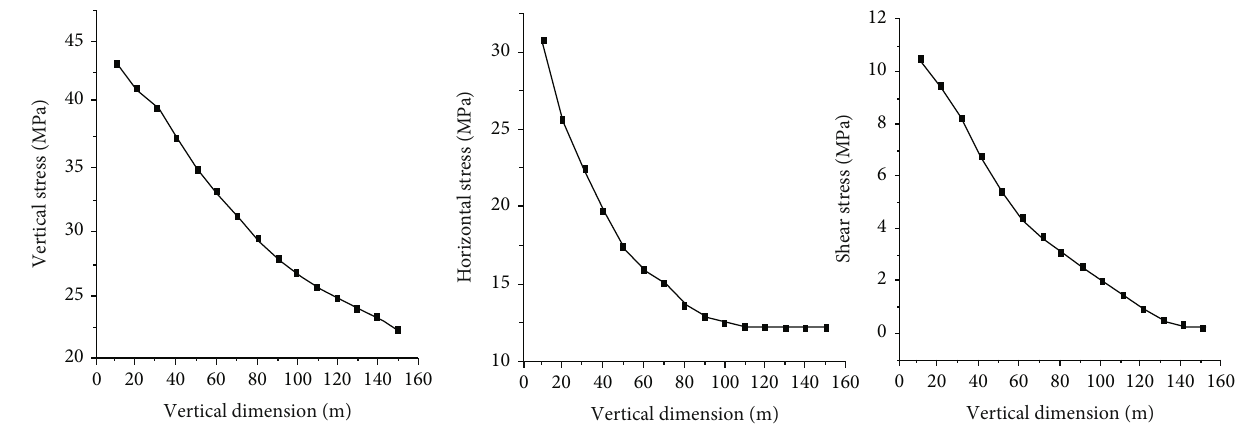
Figure 6: Variations in the roof stress as a function of the distance of the J coal seam. Table 1: Rock distribution and its physical